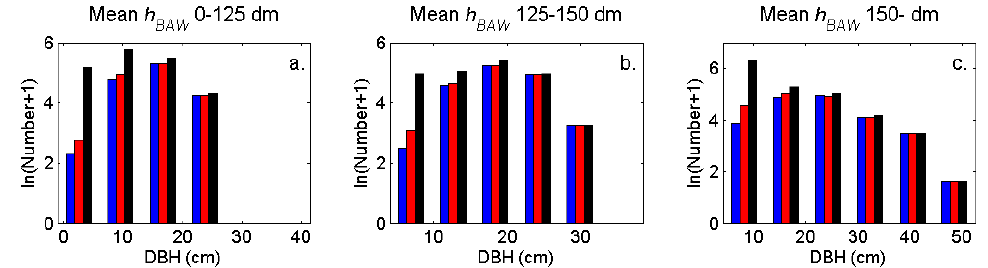
Figure 8. The DBH distributions (log scale) in the strata defined in Table 1 for the segments (blue), the trees linked to clusters (red), and the field-measured trees